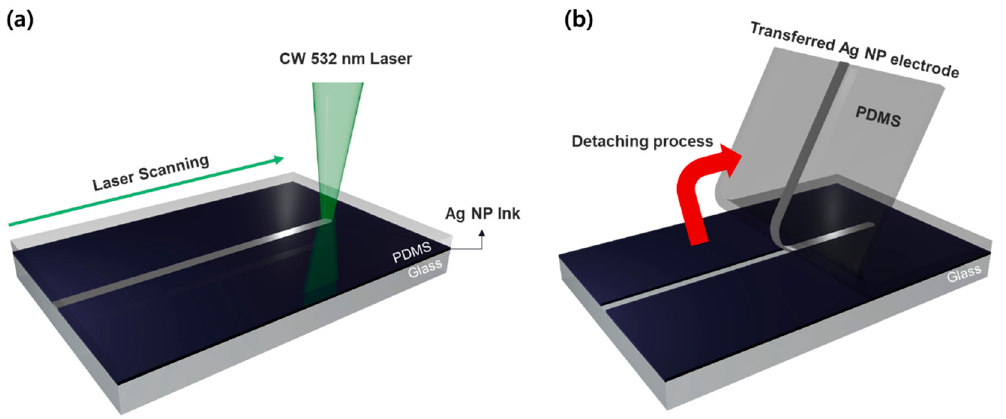
Figure 1. Schematics of the shear-assisted laser transfer of Ag NP ink to the elastomer substrate: ( a ) Laser is focused and scanned on the Ag NP ink, which is sandwiched between the glass substrate and the PDMS film; ( b ) Detaching process after the laser scanning verifies that the Ag NP is selectively sintered and transferred to the PDMS film.